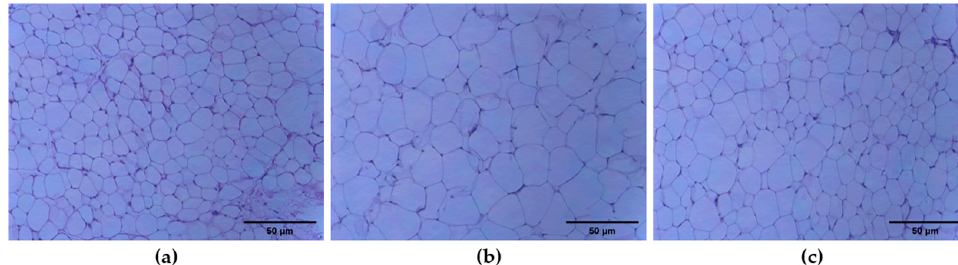
Figure 6. Effect of Jeju barley extract (BEE) on the histopathological change in epididymal fat tissues in the high fat diet-induced C57BL/6 mice. Epididymal fat tissues were stained with H&E (original magnification ×100). ( a ) Normal diet mice, ( b ) high fat diet mice, ( c ) high fat diet treated with BEE 0.3 g/kg-body weight.